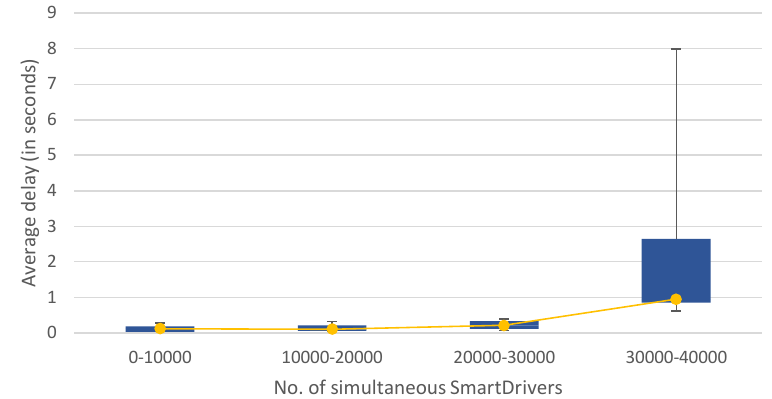
Figure 9. Number of simultaneous drivers that can be served and response delay for three centralised- cloud FIWARE servers (see [53] for more details). The timeout threshold considered is 5